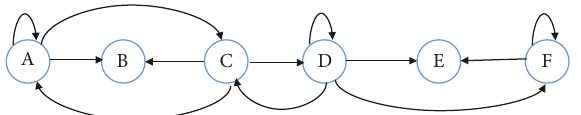
Figure 1: An example RBN ( N = 6, K = 2). The nodes and links are represented by circles and arrows, respectively.